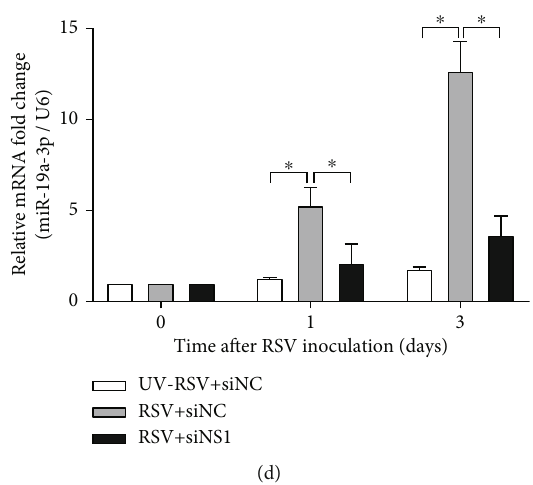
Figure 1: RSV NS1 protein upregulates the expression of miR-19a-3p in A549 cells. (a) Western blot analysis of NS1-FLAG protein in A549 cells transfected with pNS1. Anti-FLAG antibodies were used to assess for the presence of FLAG-tagged NS1. β -Actin was used as an internal control. (b) The expression levels of miR-19a-3p mRNA at di ff erent time points after pNS1 transfection. U6 RNA was used as an internal control. (c) Localization of NS1 (green) in A549 cells transfected with pNS1 was analyzed by immuno fl uorescence confocal microscopy at four hours after transfection. Anti-FLAG antibodies were used to assess for the presence of FLAG-tagged NS1. Nuclei were counterstained with DAPI (blue). Representative images were shown. (d) The expression levels of miR-19a-3p mRNA in A549 cells at di ff erent time points after RSV inoculation. Monolayers of A549 cells were infected for 72 hours with ultraviolet-inactivated RSV or live RSV. Cells were pretreated with siNC or siNS1 for 6 hours prior to RSV inoculation. U6 RNA was used as an internal control. Data are expressed as mean ± SD ( n = 3 technical replicates). The experiment was performed three times with similar results, and one representative experiment is shown. ∗ P < 0 : 05 vs. 0 h. NS1: nonstructural protein 1; pNS1: nonstructural protein 1 expressing plasmid; DAPI: 4 ′ ,6-diamidino-2-phenylindole; RSV: respiratory syncytial virus; UV-RSV: ultraviolet-inactivated RSV; siNC: negative control siRNA; siNS1: RSV NS1